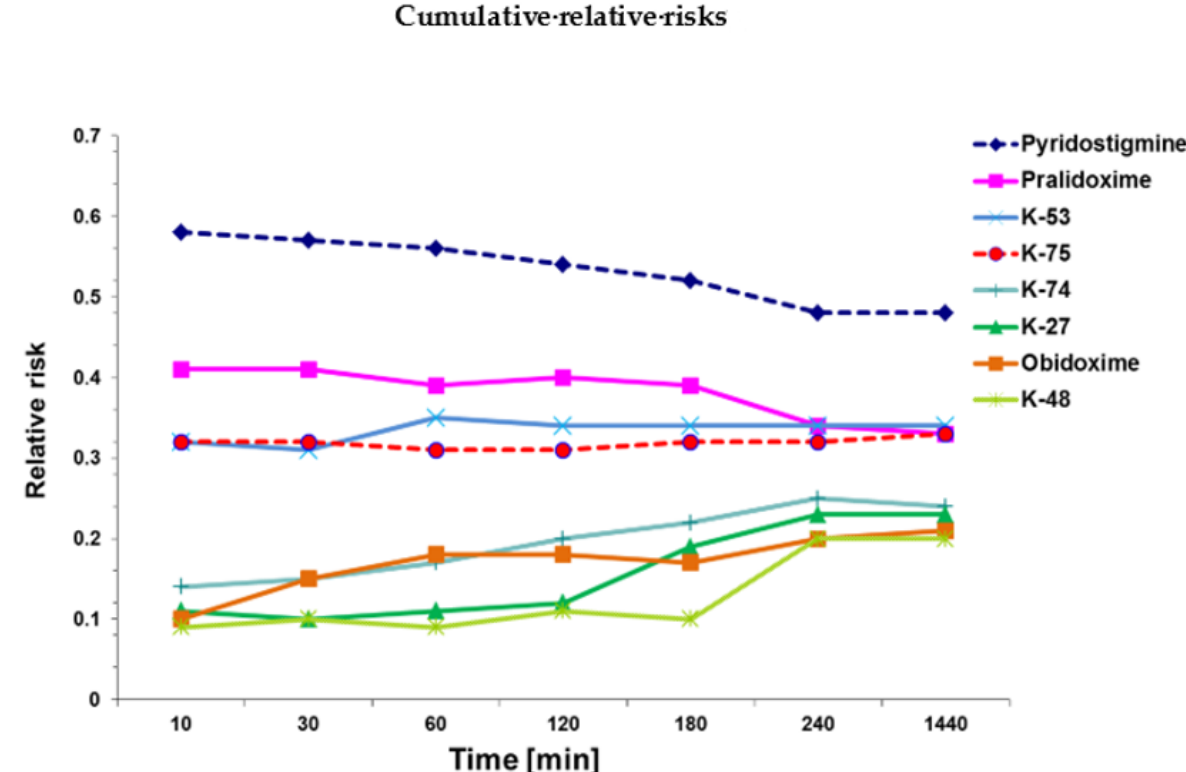
Figure 1. Relative risk (RR) of death, estimated by Cox [42] analysis in animals exposed to intraperitoneal (i.p.) injections of azinphos-methyl and adjusted for azinphos-methyl dose (high/low) for each of the time points examined (10 min, 30 min, 1 h, 2 h, 3 h, 4 h, 24 h, 48 h). The acetylcholinesterase (AChE) inhibitor pyridostigmine or the oxime-type AChE reactivators pralidoxime, obidoxime, K-27, K-48, K-53, K-74 or K-75 were administered prophylactically 30 min before azinphos-methyl exposure, and the protection conferred by these compounds was compared with the reference group (azinphos-methyl alone, no pretreatment: RR = 1). The injected dose for pretreatment was approximately ¼ the LD 01 . The most successful prophylactic compound was K-48, reducing the relative risk of death to about 8% (RR = 0.08) after 10 min and to about 20% (RR = 0.20) after 48 h (1440 min). Pretreatment with pyridostigmine was the least efficacious, reducing azinphos-methyl-induced mortality only to about 58% after 10 min and to 50% after 48 h.